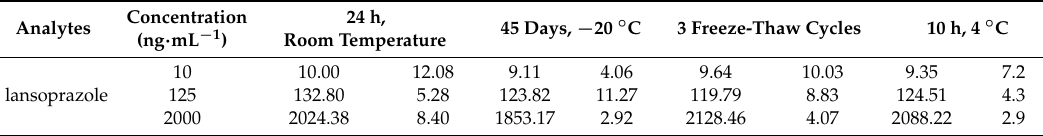
Table 5. Stability of the lansoprazole in dog plasma ( n =